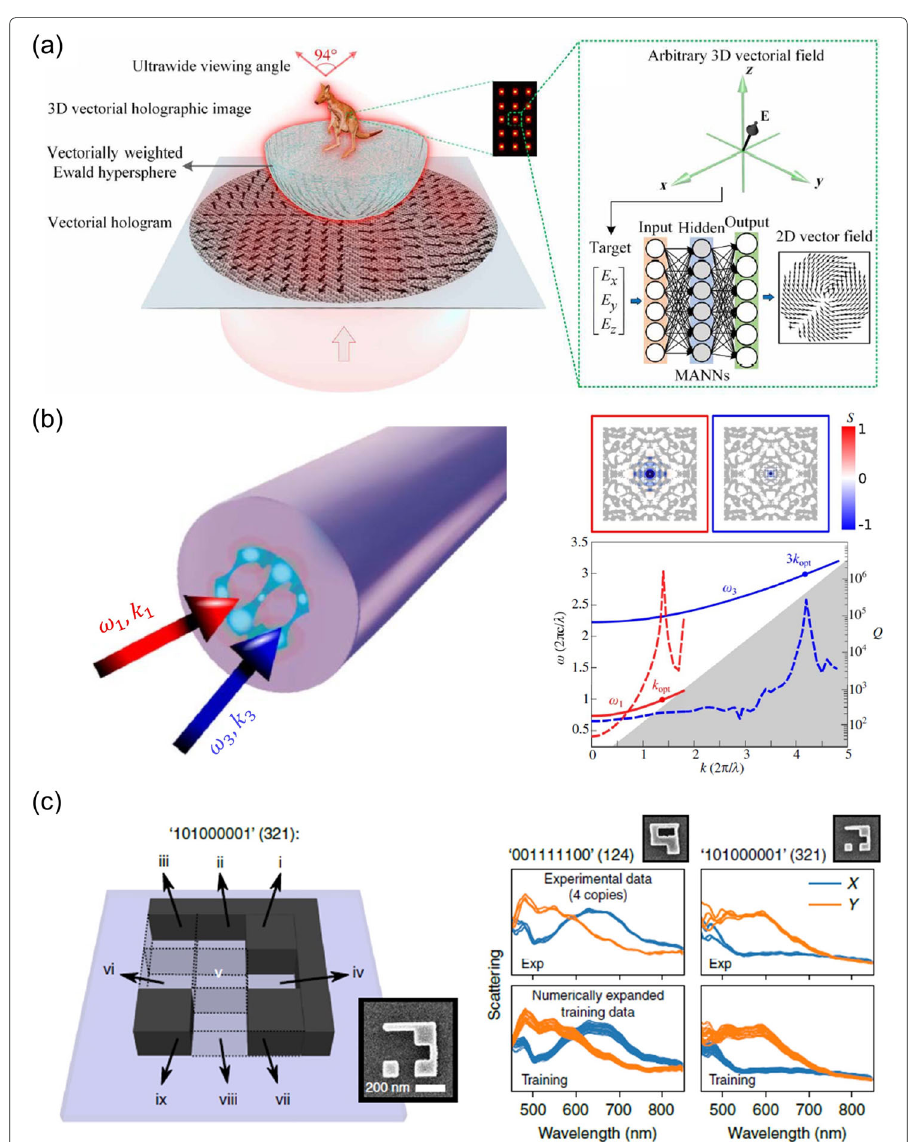
Fig. 12 (a) ANN-assisted designs of vectorial field for the optical holography. Left: a floating display of a 3D kangaroo image. The vectorial hologram incorporates a phase hologram and a 2D vector field. Right: an amplified view stressing an arbitrary 3D vectorial field originated from the ANN model. (b) TO-developed microstructured fibers for third-harmonic generation. Left: a general sketch depicting fiber geometries. Right: dispersion relations (solid line) and radiative lifetimes Q (dashed line) verses propagation constant k . The graph indicates that the optimized k opt achieves frequency matching condition and leads to a large nonlinearity. Top corner: fiber cross-sections at power density of ω 1 (red frame) and ω 3 (blue frame), respectively. (c) ANN-aided optical information retrieval from digit-encoded nanostructures. Left: a sketch of an individual geometry storing a 9-bit (e.g., ‘101000001’) data. The digits are encoded in tagged (labels of ‘i’ to ‘ix’) silicon blocks (entity: ‘1’; vacuum: ‘0’) and the added L-shaped sidewall allows to distinguish symmetric arrangements in case of polarized excitations. Right: selected examples illustrating ANN training data (lower panel) produced from a numerical expansion of the experimental spectra (upper panel). The legend of ‘X’ and ‘Y’ denotes the applied light polarizations, i.e., X for vertical direction and Y for horizontal orientation. Figures reproduced with permission: (a) Ref. [136], Copyright 2020 AAAS; (b) Ref. [137], Copyright 2018 OSA; (c) Ref. [138], Copyright 2019 Nature Publishing